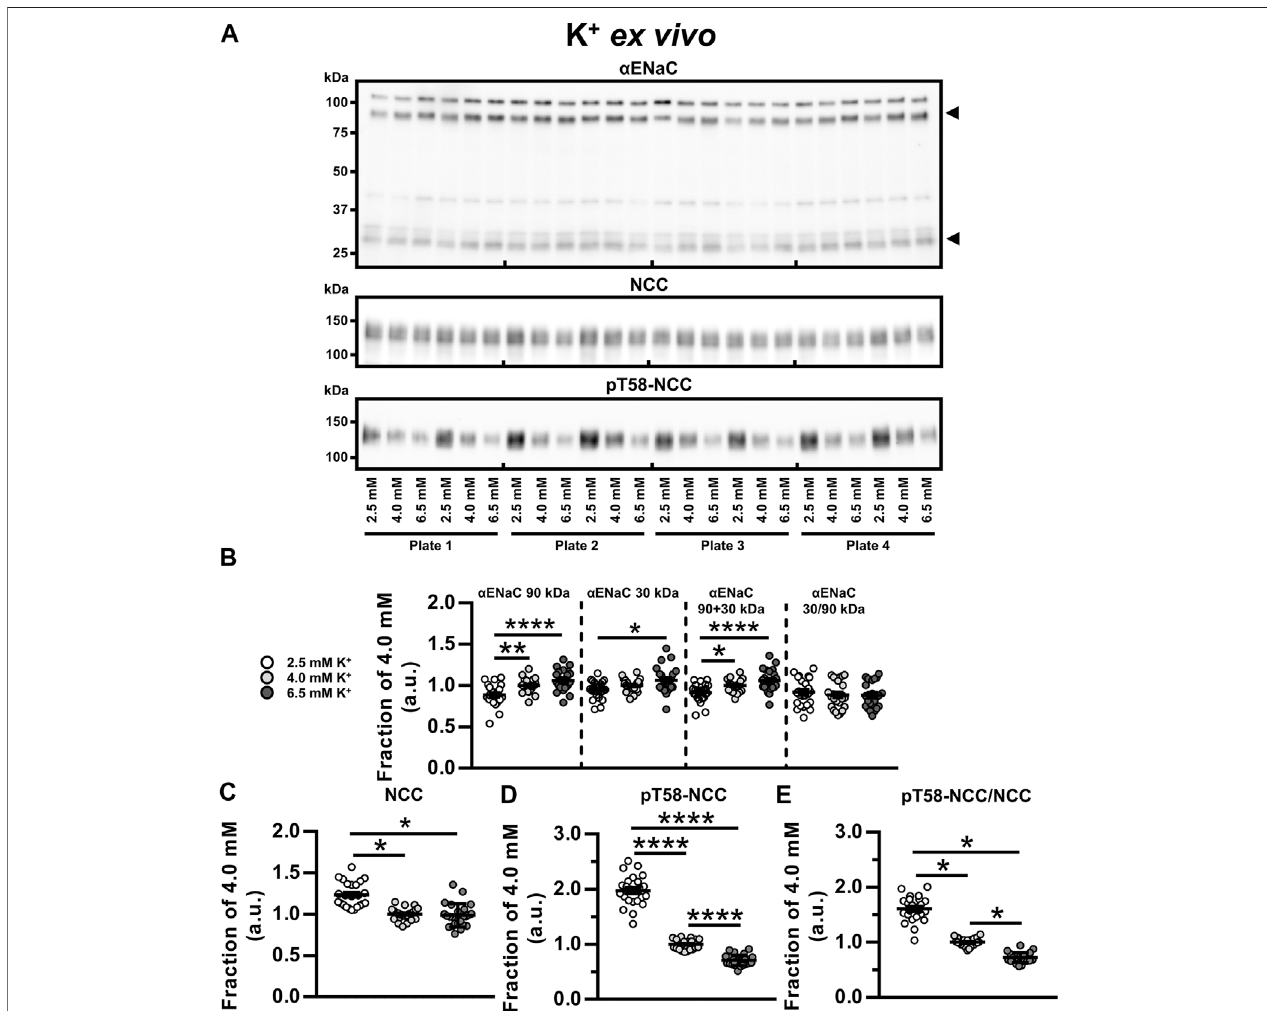
FIGURE 4 | Low K + reduced α ENaC but increased NCC and pT58-NCC ex vivo . (A, B) Semiquantitative immunoblotting showed that ex vivo exposure of kidney tubulesuspensionsfor21hto2.5 mMK + ,ascomparedto6.5 mMK + ,signi fi cantlyreducednon-cleaved α ENaC(90 kDa),cleaved α ENaC(30 kDa)andtotal α ENaC(90 + 30 kDa). (A,C) Exposure to 2.5 mM K + increased NCC compared to 4.0 and 6.5 mM K + . (A,D,E) Exposure to 2.5 mM K + increased pT58-NCC and the pT58-NCC/ NCC ratiocompared to4.0and 6.5 mMK + .Moreover,6.5 mM K + reducedpT58-NCC andthepT58-NCC/NCC ratiocompared to4.0 mMK + .Experiments were perform in 6-well plates and quanti fi ed values were normalized to 4.0 mM K + within individual plates. Data from three individual experiments were pooled. Data are presented as dot plots and mean ± SEM. n = 24 per group. Statistical comparisons were performed using a one-way ANOVA followed by post-hoc testing with FDR- correction ( α ENaC 90 kDa, α ENaC 90 + 30 kDa, α ENaC 30/90 kDa and pT58-NCC) or Kruskal – Wallis ANOVA on Ranks ( α ENaC 30 kDa, NCC and pT58-NCC/NCC). * p < 0.05, ** p < 0.01**, **** p < 0.0001.